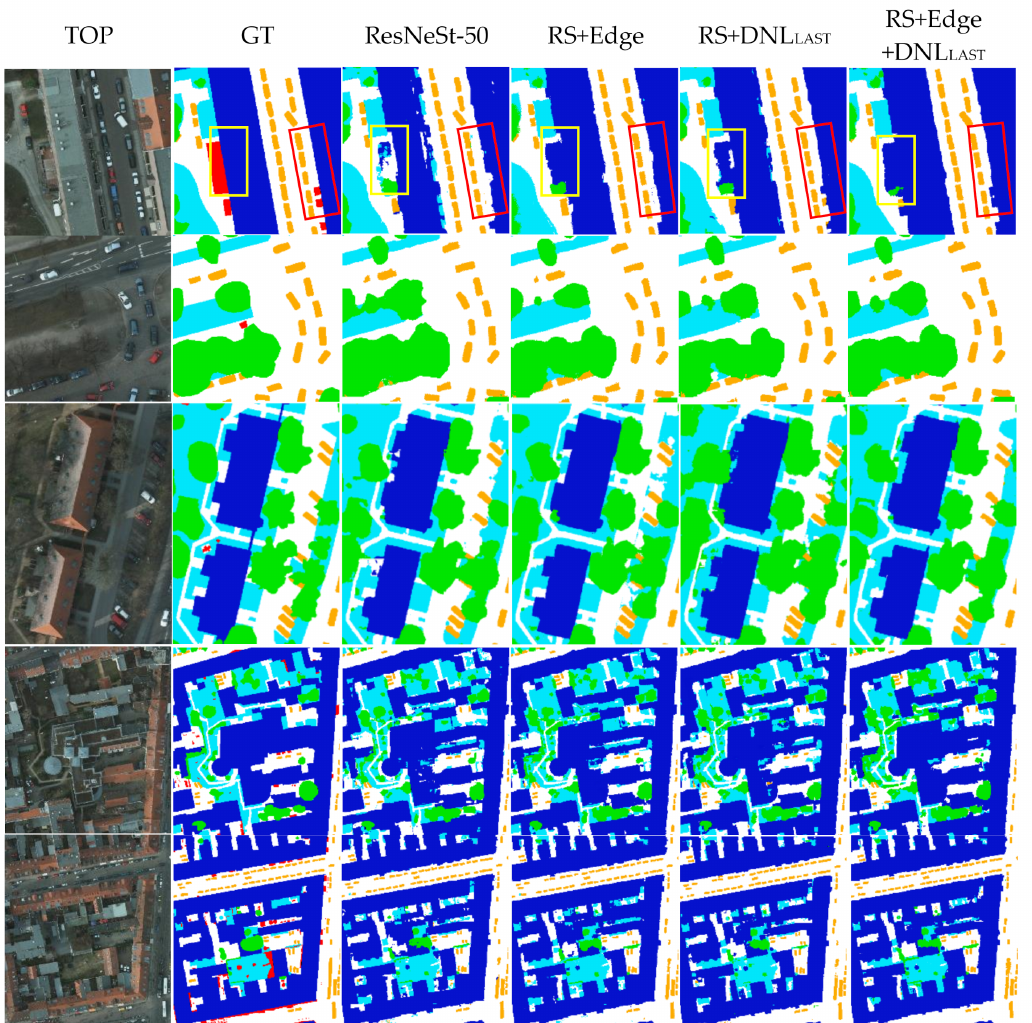
Figure 9. Example predictions on the Potsdam dataset. The 3rd to 6th columns show the results of ResNeSt-50, ResNeSt+Edge, ResNeSt+DNL, and ResNeSt+Edge+DNL methods. ( blue : buildings, orange : cars, cyan : low vegeta- tion, white : impervious, and green : trees) The boxes marked in the first two rows are the differences between the results of multiple